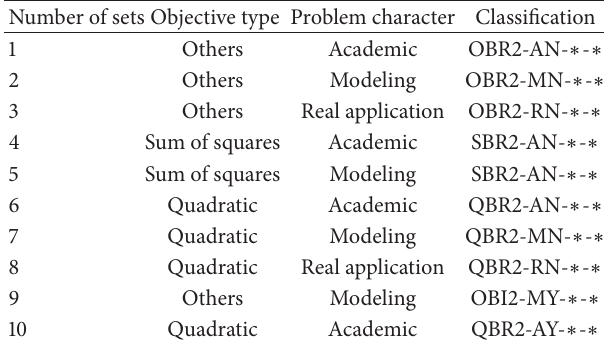
Table 1: Problem set according to the CUTEr